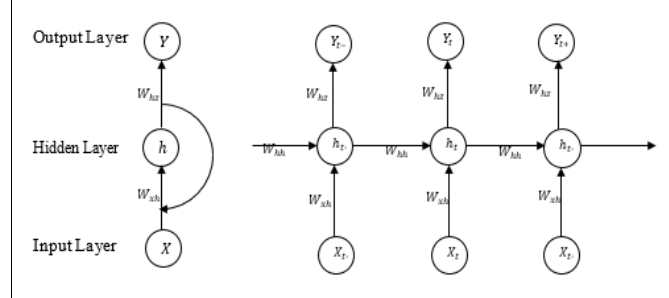
Figure 3: RNN Architecture.